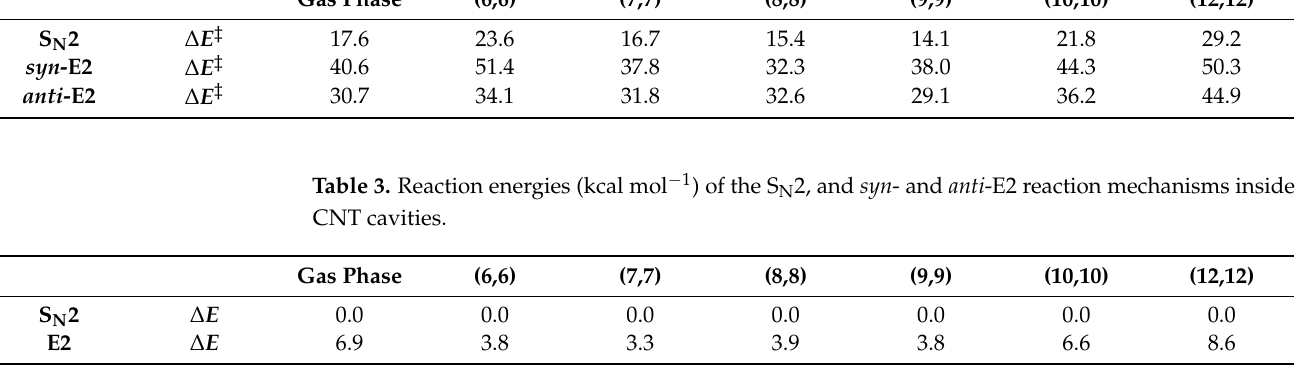
2, and syn - and anti -E2 reaction mechanisms inside N